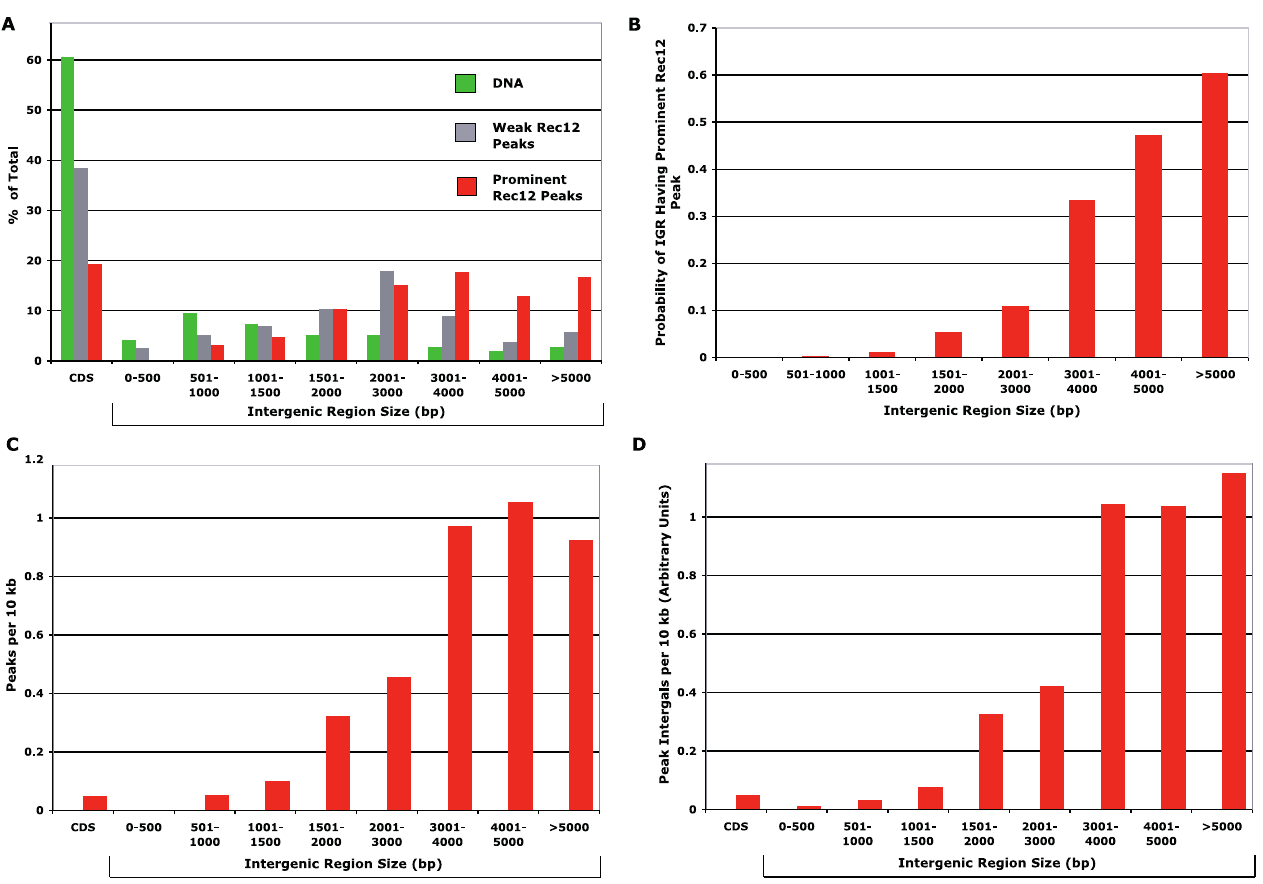
Figure 6. Most DSB Hotspots Occur in Large IGRs Frequency distributions of DNA (green bars), weak Rec12-DNA linkage sites (gray bars), and prominent Rec12-DNA linkage sites (red bars) are shown for the classes of DNA sequence indicated. Analysis was carried out using the whole genome excluding the centromeres and 50 kb at the end of each chromosomal contig (to exclude telomeric regions). (A) Number distribution. Peaks of Rec12-DNA linkage (DSB hotspots) identified from the mean of the haploid 5-h data were classified according to their position in coding sequences (CDS) or in IGRs. A total of 62% of prominent Rec12 peaks occur in IGRs . 2 kb. (B) Probability of a prominent Rec12 peak occurring within an IGR increases with IGR size. (C) Density of prominent Rec12 peaks (number of peaks per kb) increases with IGR size. (D) DSB density (Rec12 peak integrals per kb) is greatest in large